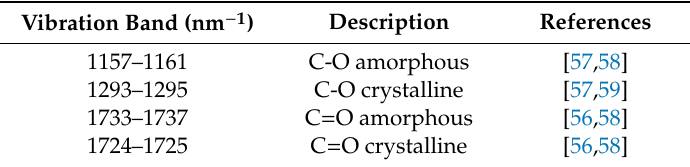
Table A1. Some characteristic vibration bands of PCL.